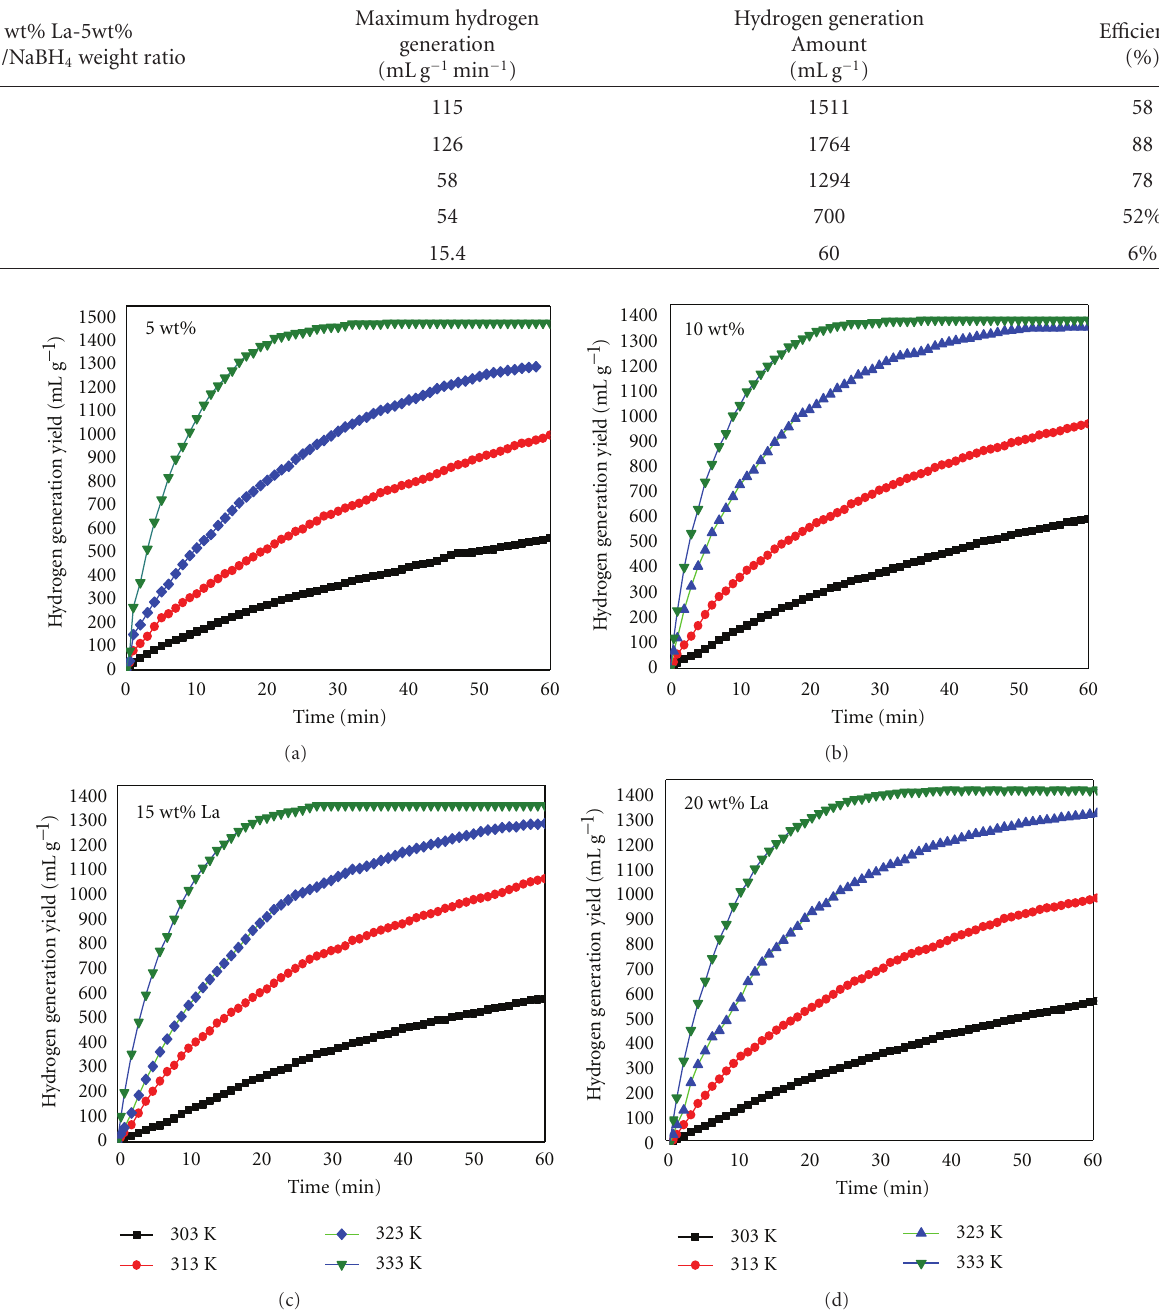
Figure 4: Hydrogen generation performance of Al- x wt.% La-5wt.% NiCl 2 /NaBH 4 mixture (weight ratio, 1: 1) at di ff erent temperatures. x : 5; 10; 15;